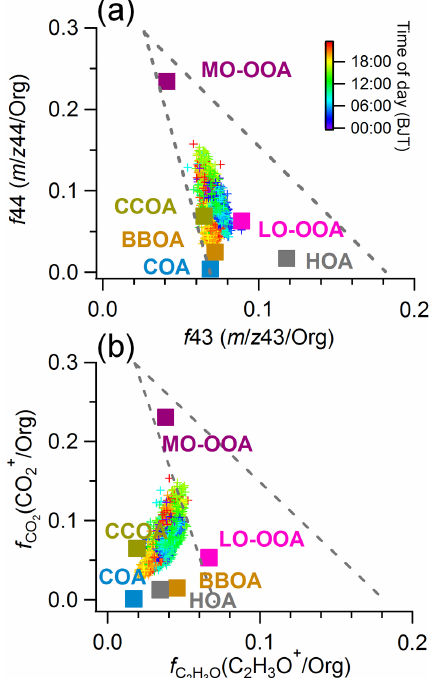
Figure 9. Scatterplots of (a) f 44 vs. f 43 and (b) f CO + f C 2 H 3 O + . The cross dots correspond to measured OA data points and are colored by time of the day. The corresponding values of the six OA factors identified in this study are also